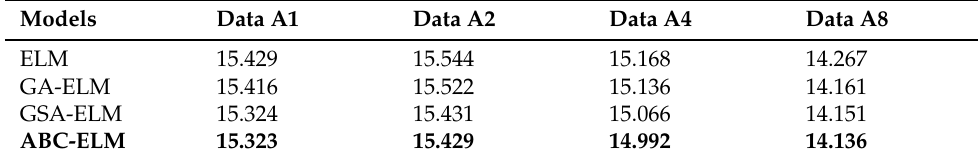
Figure 5. Comparison of MAPE values of three learning models GA-ELM, GSA-ELM, and ABC-ELM. ABC-ELM has the lowest MAPE values in all four datasets A1, A2, A4, and A8. Table 5. The comparison of AIC for four models based on